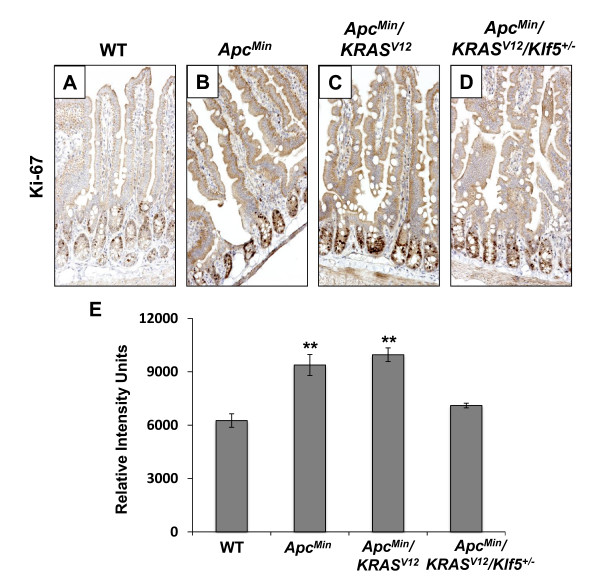
Immunohistochemical analyses of Ki67 in the normal-appearing small intestinal tissues of wild type and mutant mice. (A-D) Immunohistochemical staining of Ki67 in the normal-appearing small intestines of wild type (WT) and mutant mice. (E) Quantification of Ki67 cyclin D1 staining intensities in all fours sections using the Metamorph image analysis software. N = 10; **, P < 0.01.